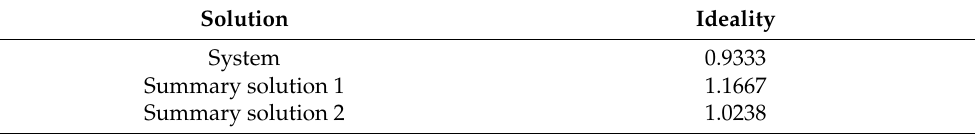
Table 4. Ideality of design